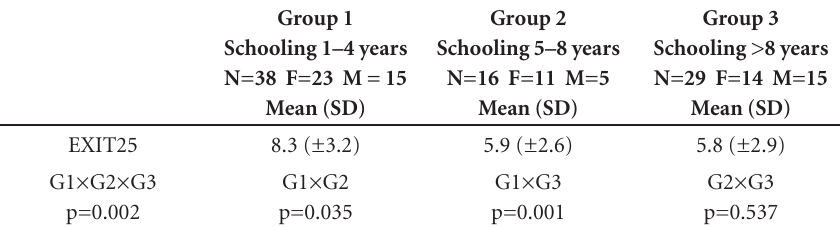
Table 2. Scores on the EXIT25 by Groups 1, 2 and